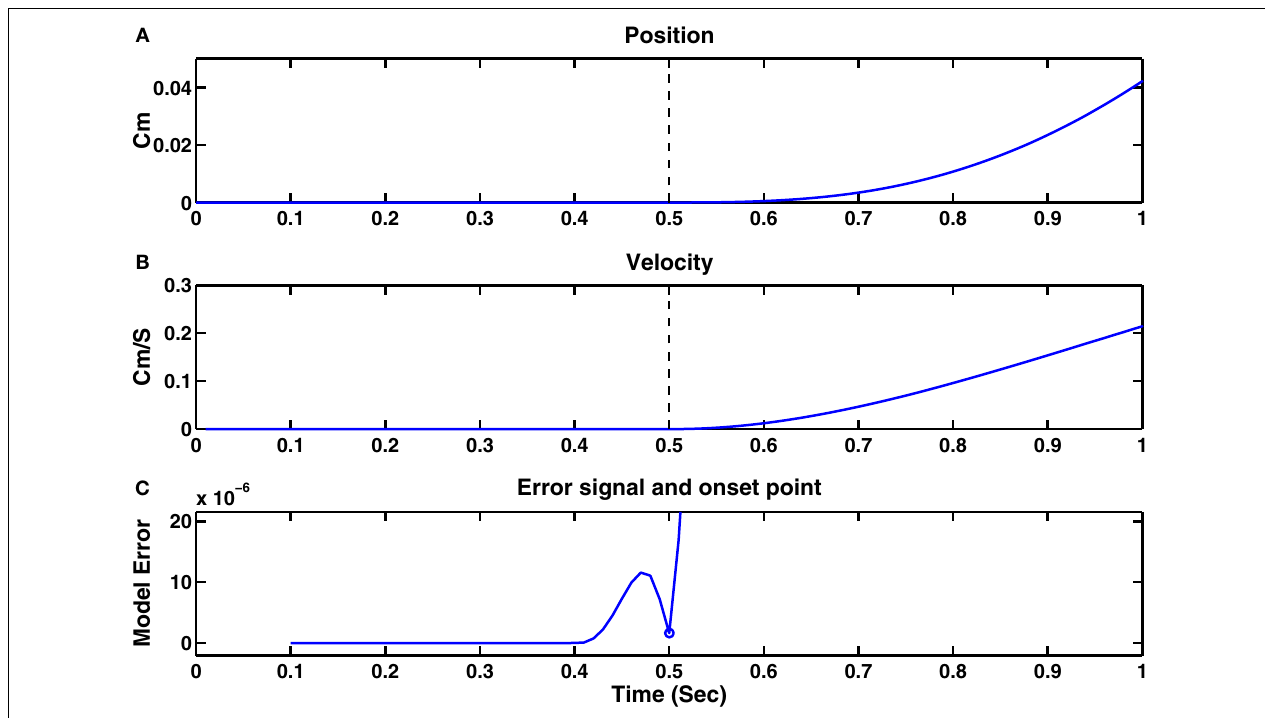
FIGURE 1 | Example of a single trajectory without noise and the estimated onset point using the MACC based onset detection model. (A) Position as a function of time; (B) velocity profi le; (C) model error (blue) and its minima defi ned as the estimated onset point (blue circle). Black dashed vertical lines on the position and velocity illustrations mark the true onset time at 0.5